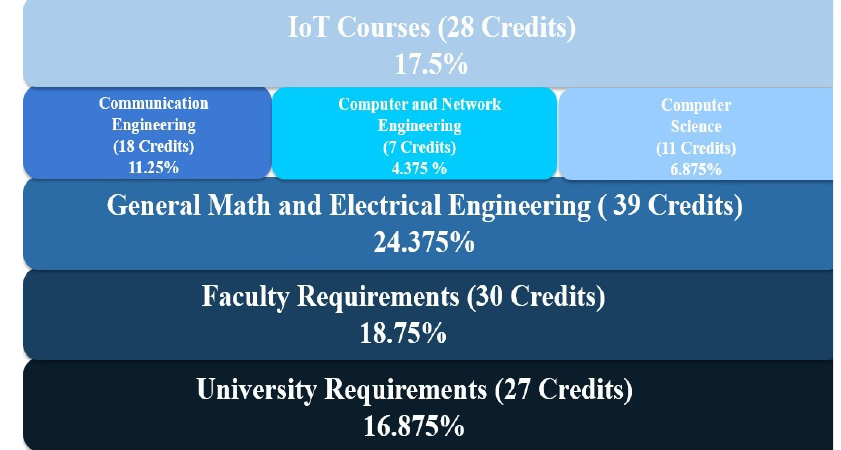
Fig. 4. Distribution of courses over study plan fields of